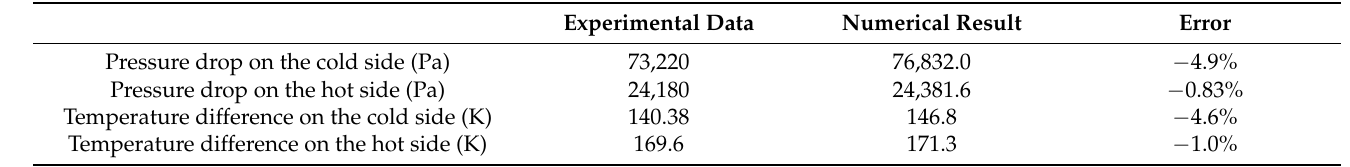
Table 2. Numerical model validation using experimental data [26].